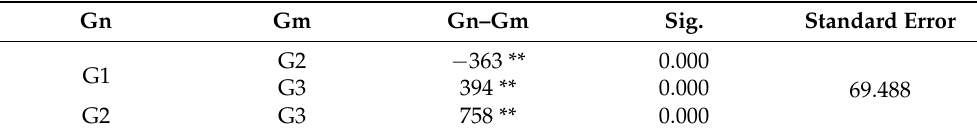
Table 6. Differences in mean yield (kg/ha) of genotypes. Gn Gm